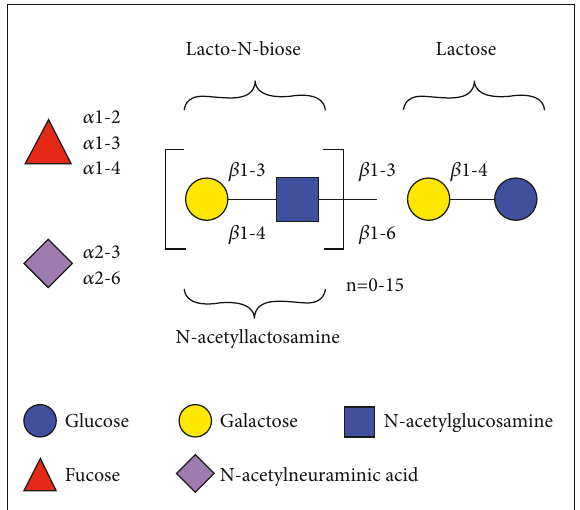
Figure 1: Structural blueprint of HMOs. The glucose, galactose, N - acetylglucosamine, fucose, and N-acetylneuraminic acid molecules are the building blocks for